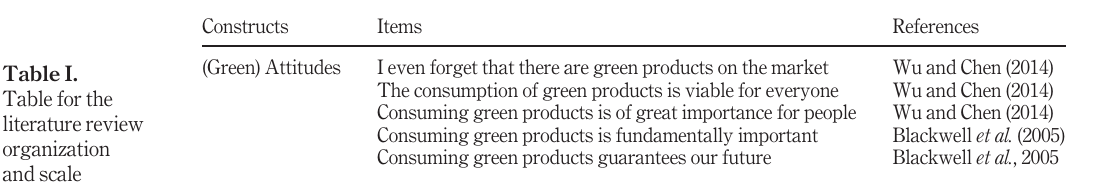
Table I. Table for the literature review